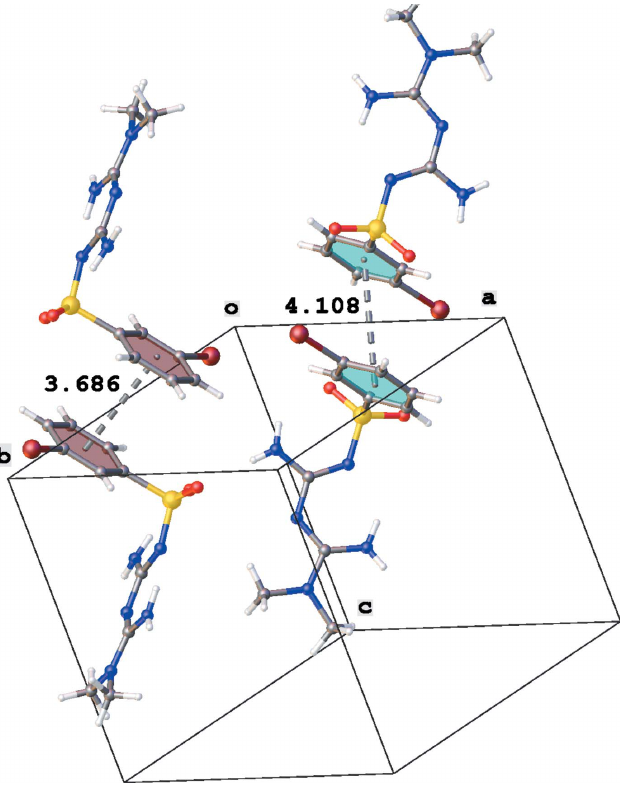
Figure 6 Partial crystal packing of the title compound, showing the (cid:2) – (cid:2) stacking between the phenyl rings. Centroid to centroid distances are given in A˚